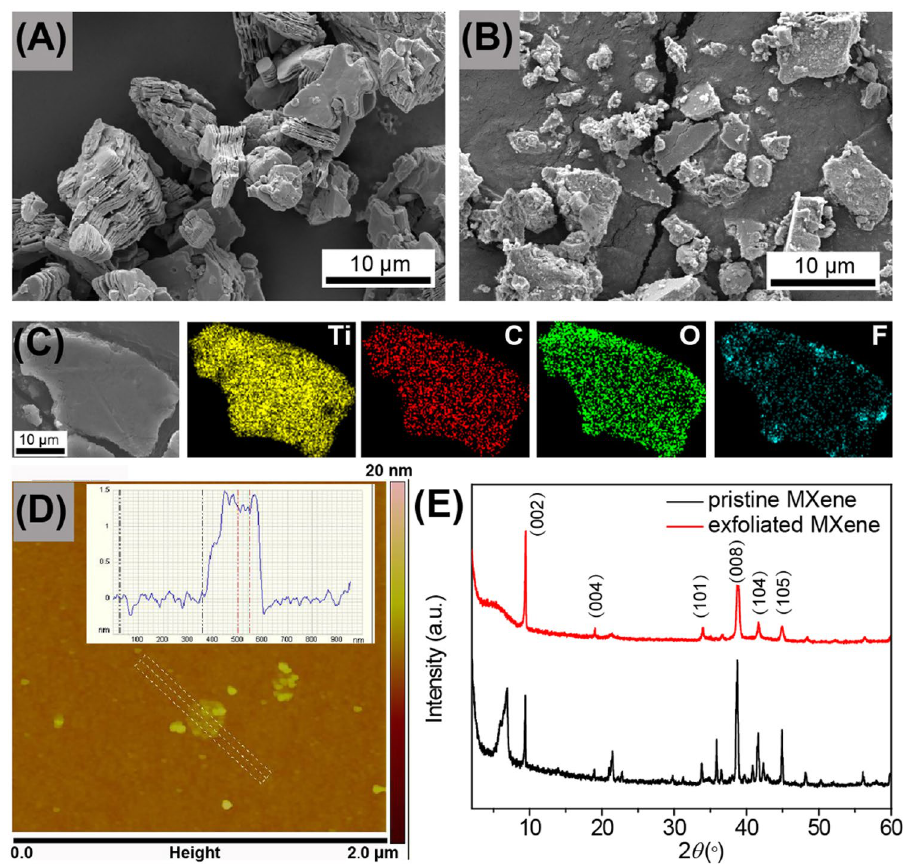
Figure 2. SEM images of (A) pristine Ti 3 C 2 T X , (B) exfoliated Ti 3 C 2 T X nanoflakes; (C) EDX elemental mapping of exfoliated